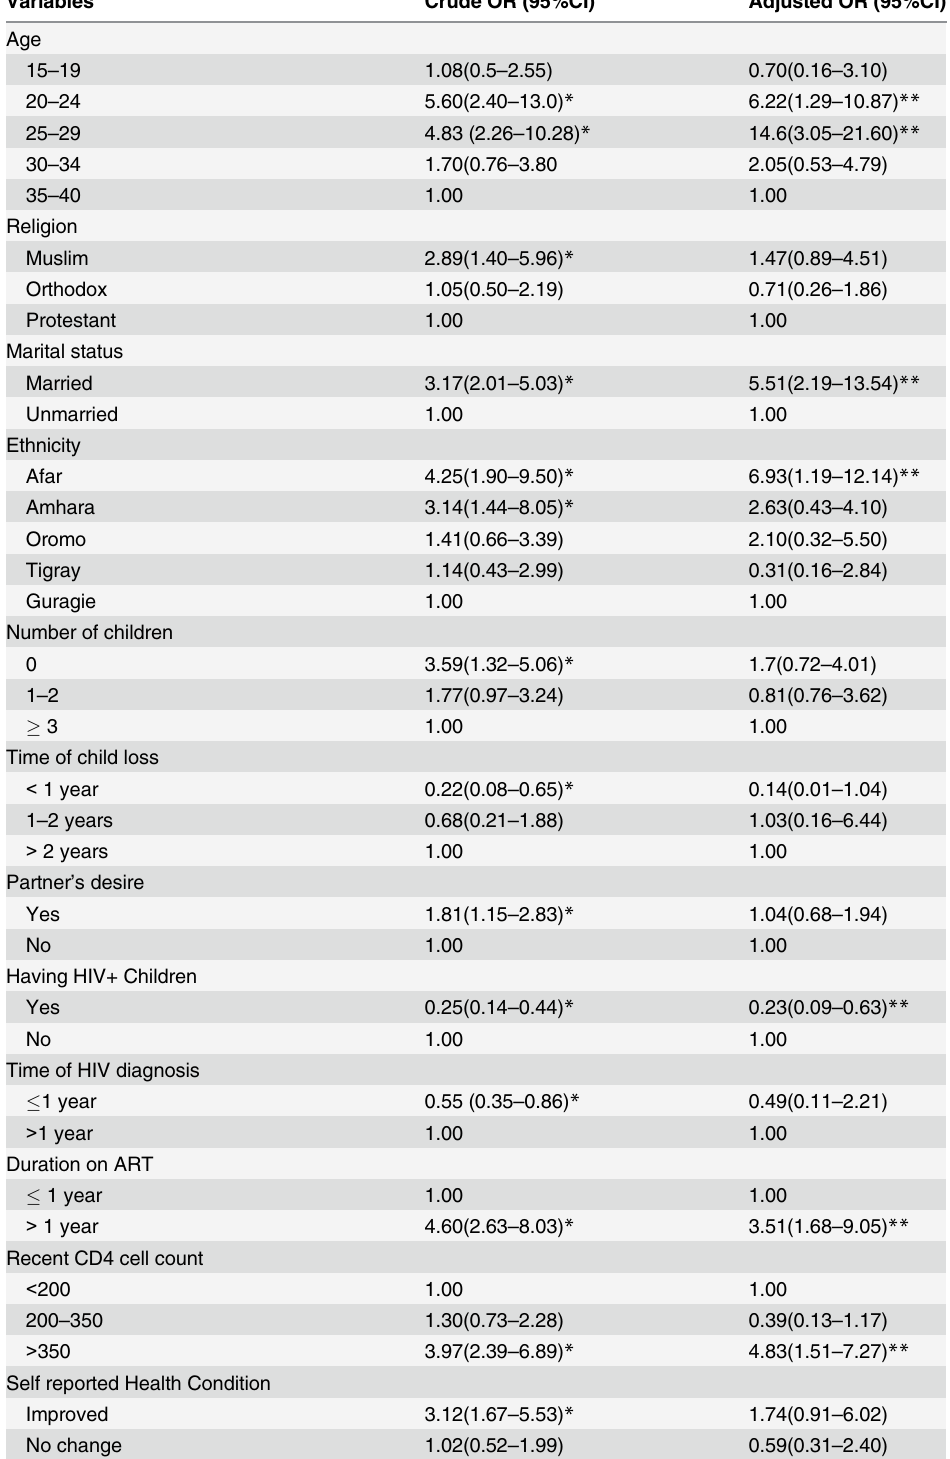
Table 4. Factors independently associated with desire for children among cases and controls of HIV positive women on ART Afar region, Ethiopia,